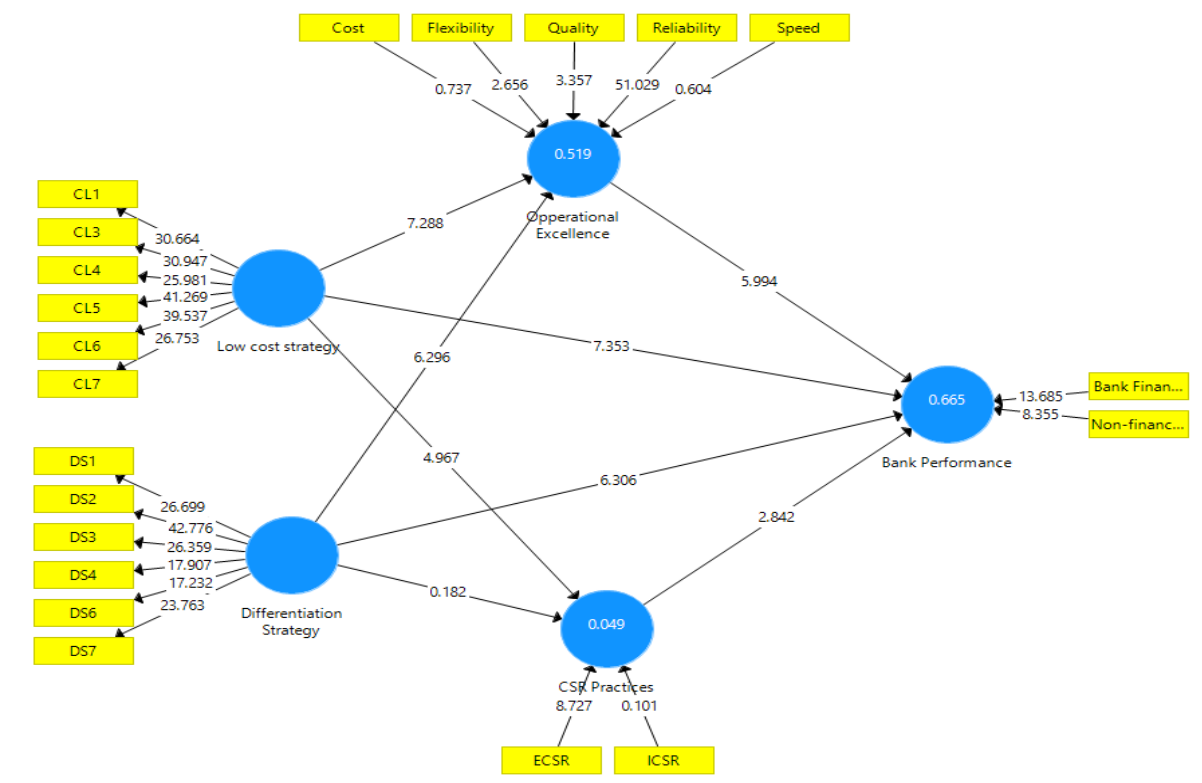
Figure 3 . Structural Model Assessment . Figure 3. Structural Model Assessment.